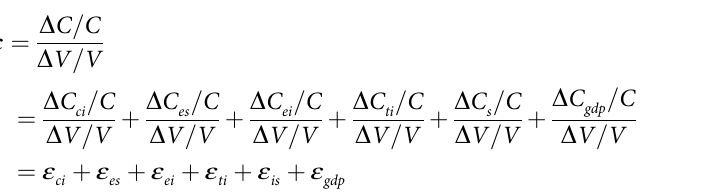
Table 1. Connotations of carbon emissions change influencing factors. Factors Connotation (during the period of 0 to t ) Δ C ci The effect of carbon emission coefficient of different energy type on carbon emission change in civil aviation sector. Δ C es The effect of energy consumption structure change on carbon emission change in civil aviation sector. Δ C ei The effect of energy intensity on the civil aviation carbon emission changes. Δ C ti The effect of transportation intensity on the civil aviation carbon emission changes. Δ C is The effect of industrial structure on the civil aviation carbon emission changes. Δ C gdp The effect of social economic output on the civil aviation carbon emission